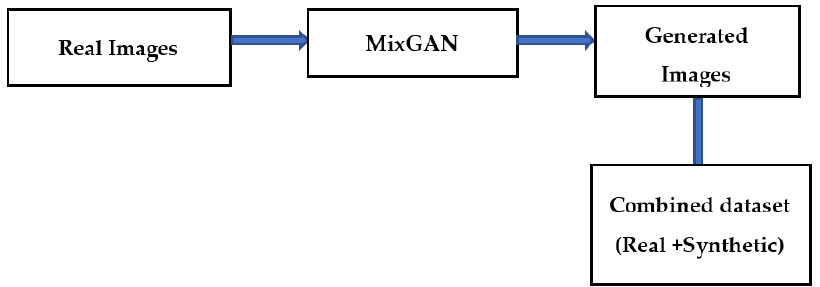
Figure 3. Data augmentation